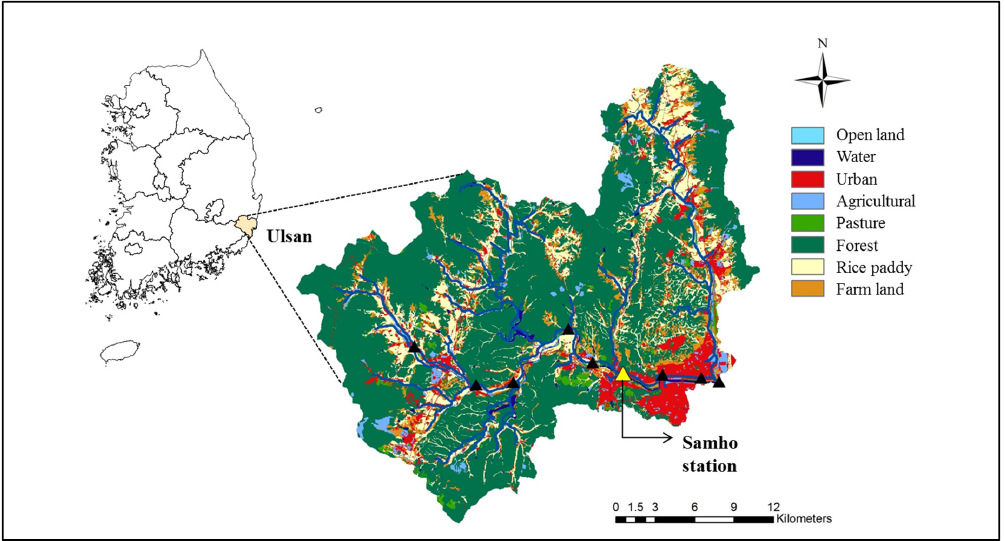
Figure 1. Land use and location of Samho station in Taehwa River watershed.